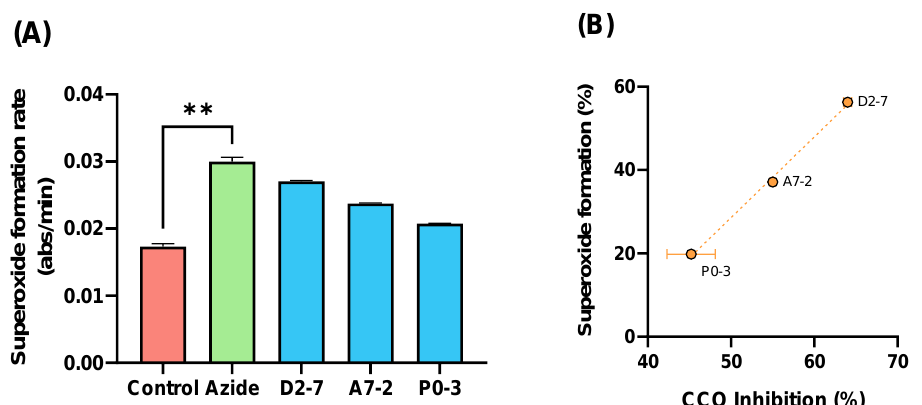
Figure 7. Diagram of the superoxide formation mediated by sodium azide and samples D2-7, A7-2, P0-3, chosen by THC content (** p < 0.01) ( A ) ( B ) . Correlation between the superoxide formation and CCO inhibition mediated by extracts D2-7, A7-2, P0-3. Both expressed as percentage vs. control. Data are mean ± SEM.